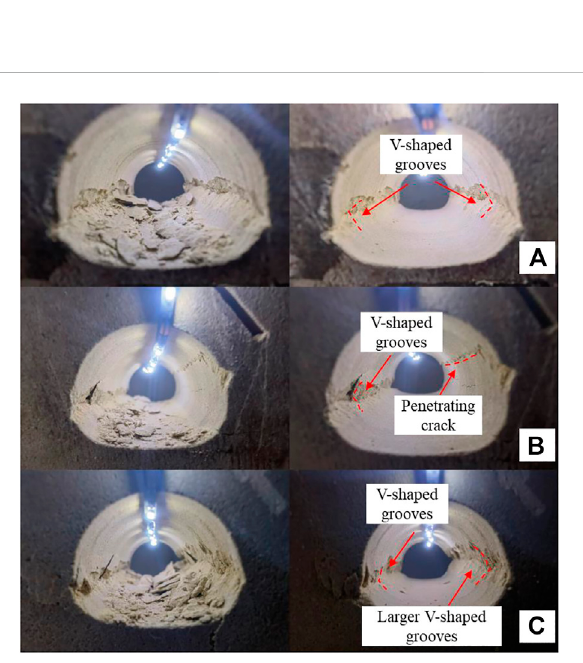
FIGURE 4 Internal images ofthetunnel beforeand after debriscleaning: (A) intact specimens; (B) open- fl aw specimens; (C) fi lled- fl awspecimens.